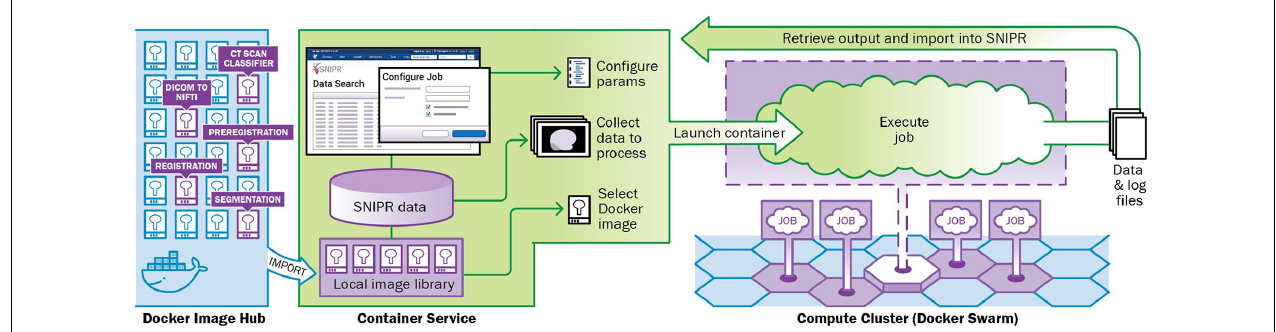
FIGURE 3 | SNIPR is equipped with a container service plugin to manage cluster of containers with Docker swarm on computing cluster attached. Containers used in SNIPR pipelines such as CT scan classifier, DICOM to NIFTI, preregistration, registration, and segmentation are pushed to and pulled from Docker image hub.